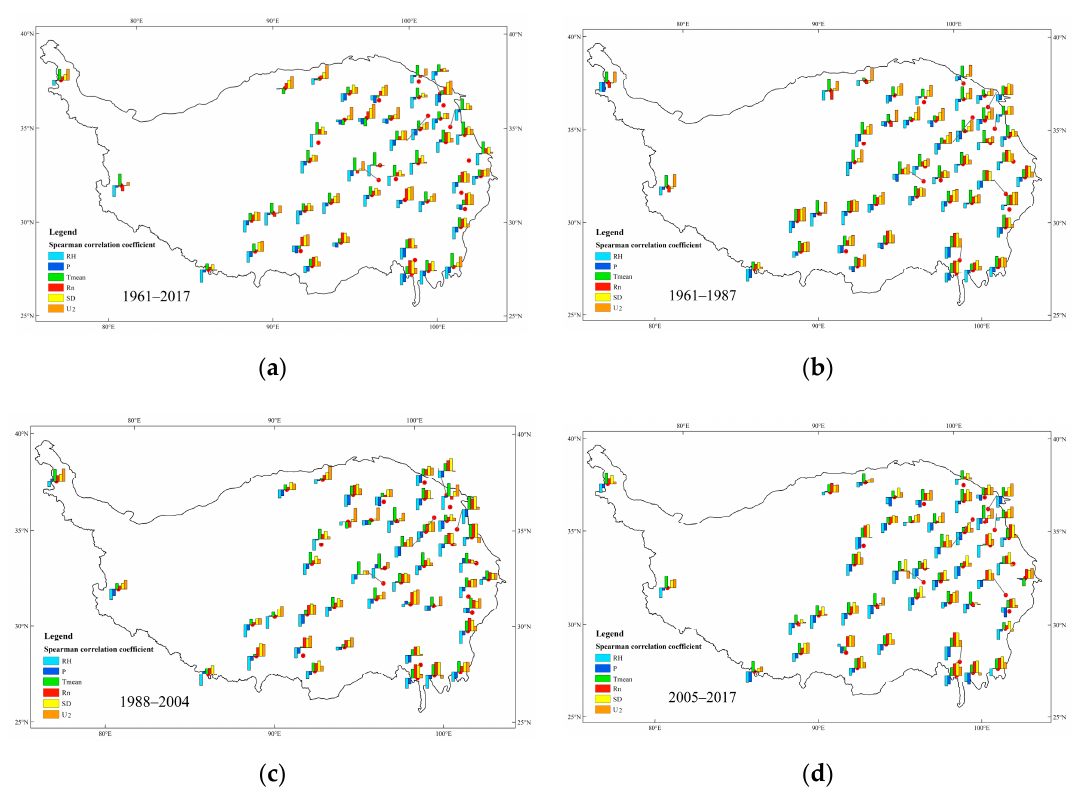
Figure 13 Figure 13. Distribution of correlation between the ET 0 and other factors; ( a ) 1961–2017, ( b ) before the first abrupt change (1961–1987); ( c ) between two abrupt changes (1988–2004); ( d ) after the second abrupt change